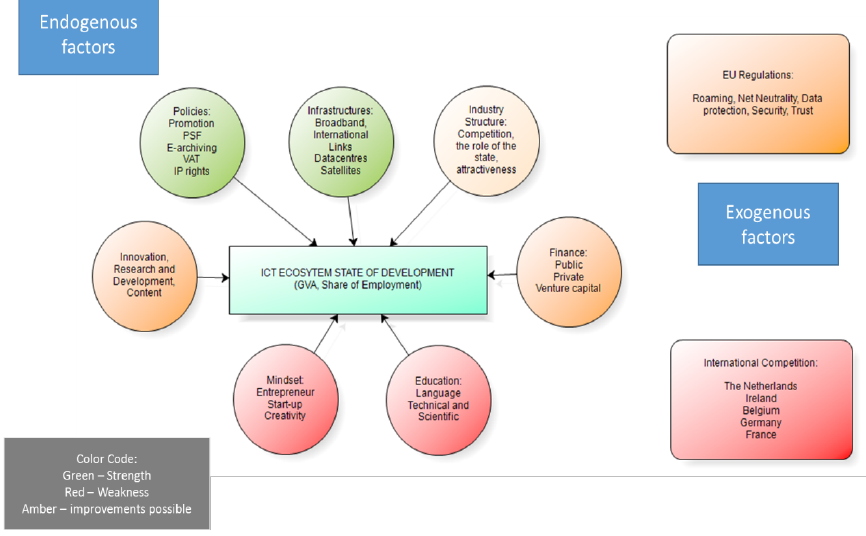
Fig 11. Summary overview of main forces affecting Luxembourg's ICT ecosystem Participants confirmed that, according to them, Luxembourg has been successful in developing its ICT sector over the past 15 years, which is reinforced by international rankings and comparisons and ‘official’ reports. The government’s initiatives have contributed to developing the underlying ICT infrastructures in terms of international connectivity, broadband and ultra-high broadband access as well as datacenter infrastructures. However, several participants also discussed the fact the success should not be defined and measured in terms of infrastructures alone and raised questions about the sustainability of this “kind of success”. This was also confirmed by a recent public debate about the demand for datacenters (Labro, 2015) and uptake of broadband connectivity (Thiel,